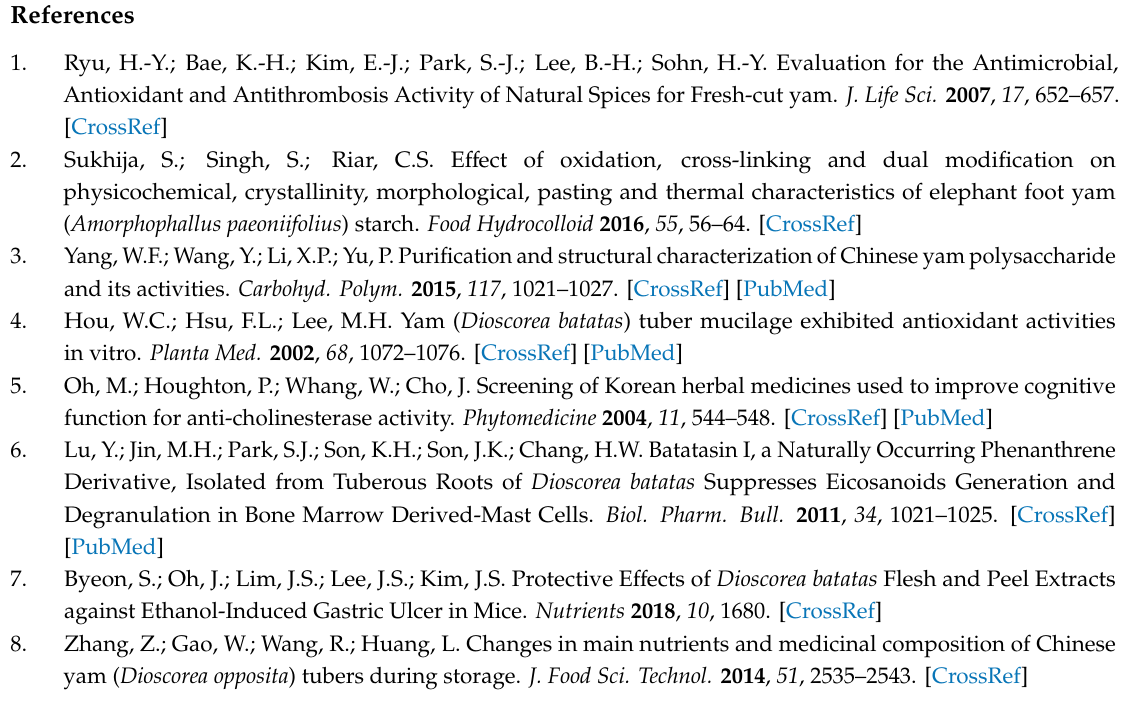
Figure S1: 1 H and 13 C NMR spectrum of Compound 1 , Figure S2: 1 H and 13 C NMR spectrum of Compound 2 , Figure S3: 1 H and 13 C NMR spectrum of Compound 3 , Table S1: DPPH radical scavenging activity of Compounds 1–3 , the DBP and DBF extracts., Table S2: ABTS + radical scavenging activity of Compounds 1–3 , the DBP and DBF